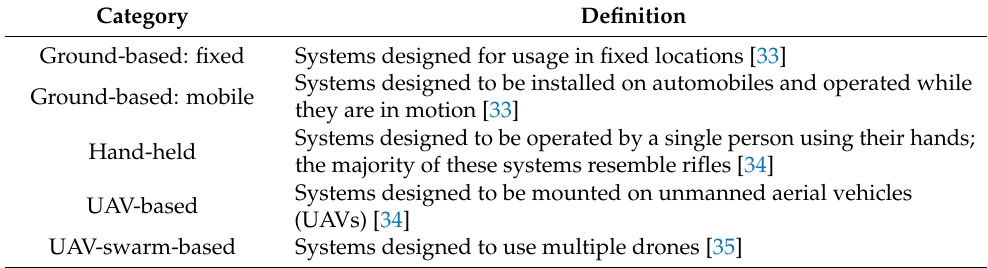
Table 3. Classification of DDDSs.